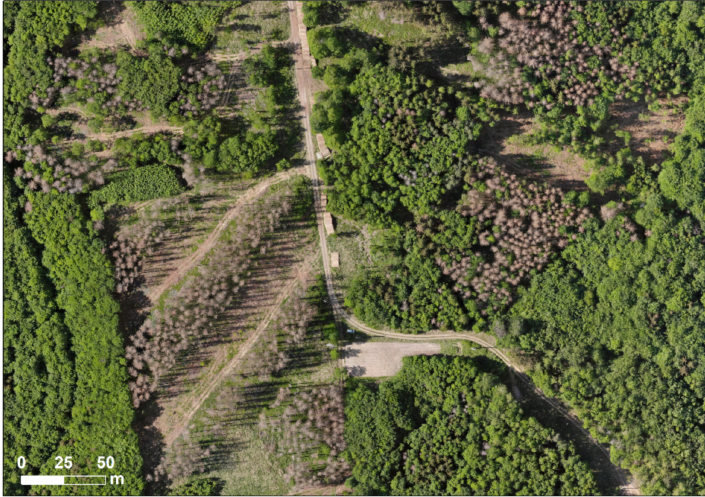
Figure 1. Trees infested by bark beetles ( Ips typographus L.) in the study area. True colour orthophoto with 6 cm spatial resolution captured on 17 / 05 /